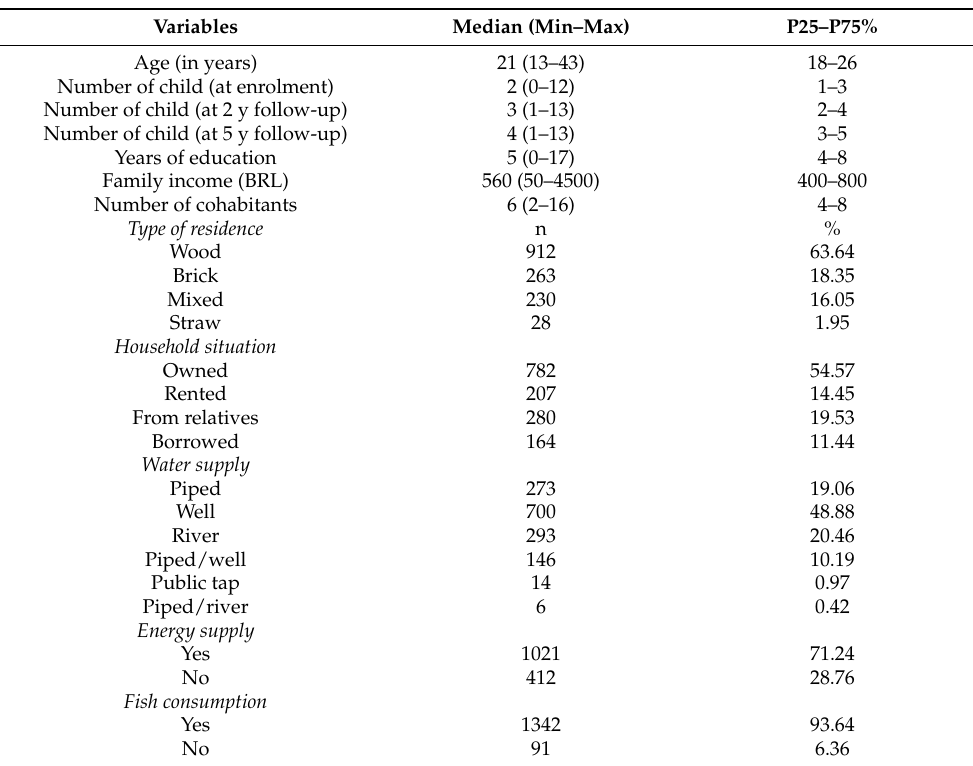
Table 1. Socioeconomic and demographic characteristics of studied women (n = 1433), Rond ô nia State, Brazilian